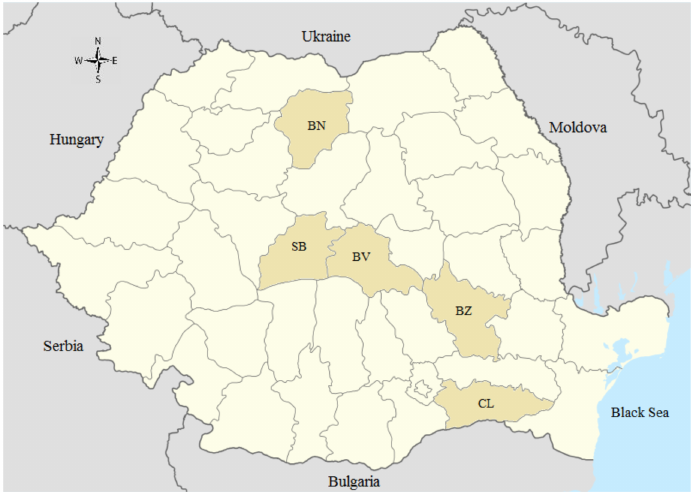
Figure 1. Map of Romania showing counties where horse sampling was carried-out. BN—Bistrita Nasaud; SB—Sibiu; BV—Brasov; BZ—Buzau; CL—Calarasi. Horses were actively racing and reared in stud farms and in small individual farms (working horses) located in hilly and lowland areas of Romania. Details related to age, gender, health status, breed, use, and origin were registered for each